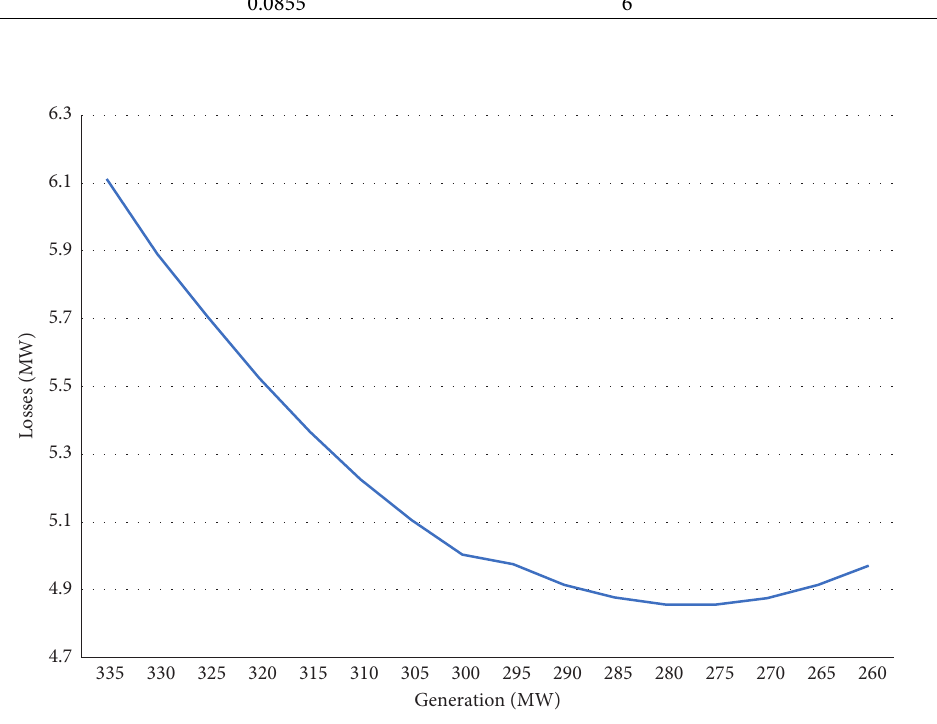
Figure 3: Line losses versus generation deficit.